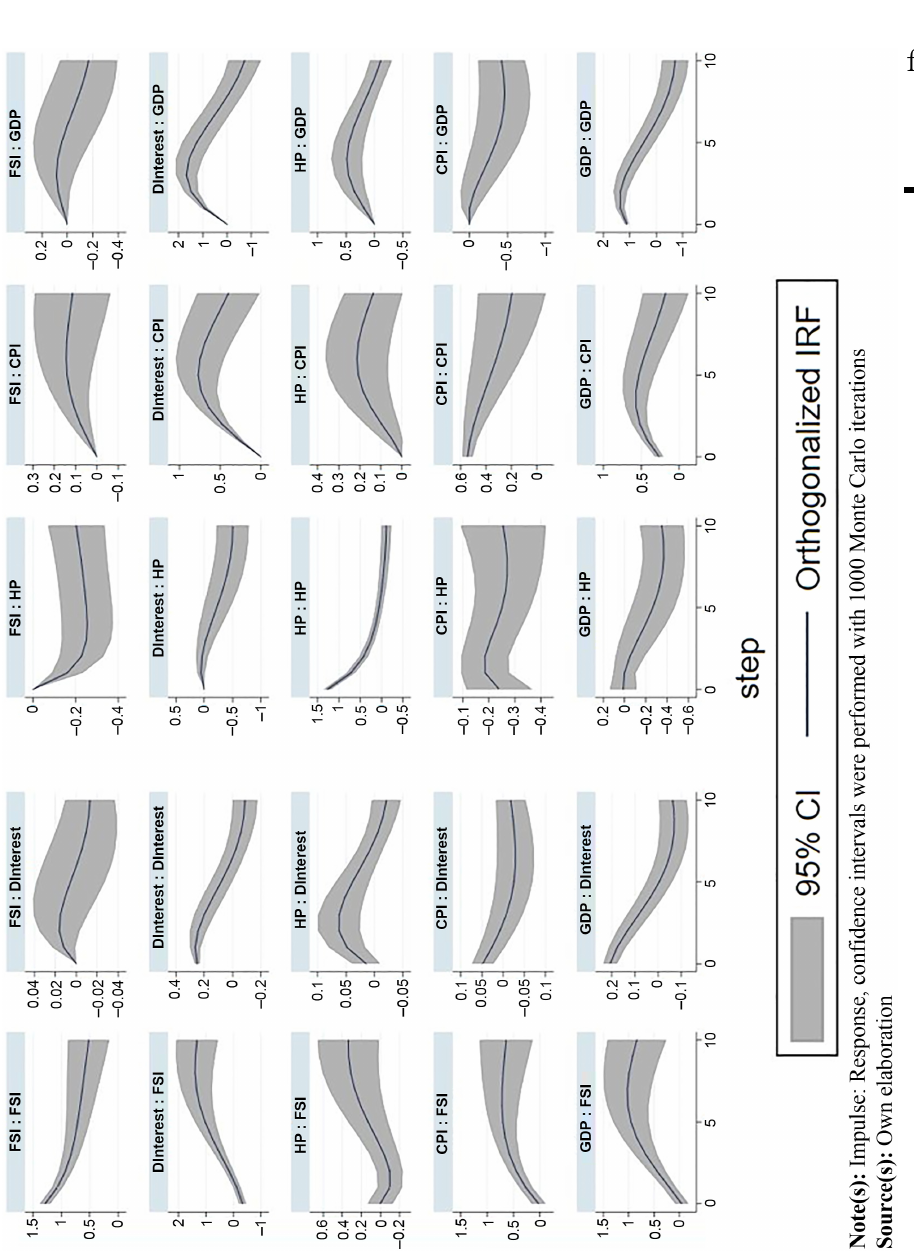
Figure 4. IRFs of the extended model for advanced